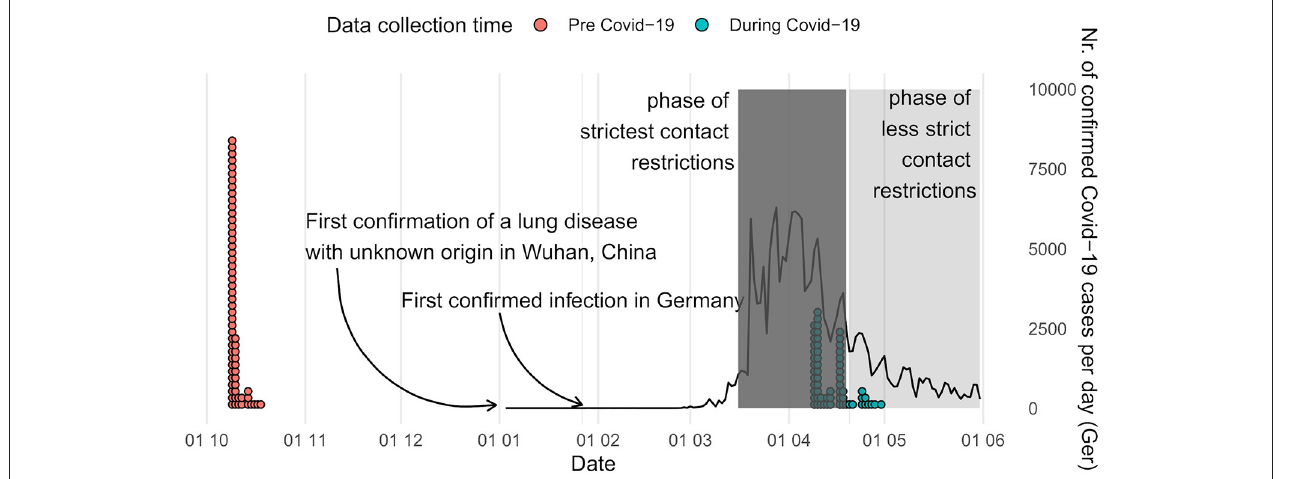
FIGURE 1 | Time of data collection and overview of the development of the COVID-19 pandemic in Germany [(20); https://covid19.who.int/table]. Contact restrictions included cancellation of mass events, ban on gatherings of more than two persons, instructions to maintain a distance of more than 1.5m to others, school and day care center closures as well as closures of all public spaces (e.g., playgrounds) and non-essential stores. Face masks in stores and public transport became mandatory on April 27.